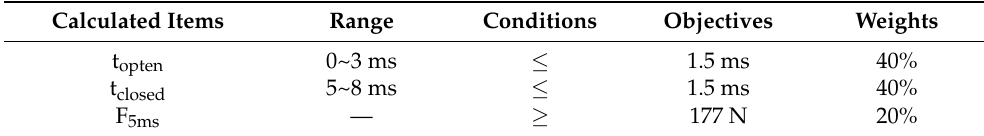
Table 5. Properties of the solved target.